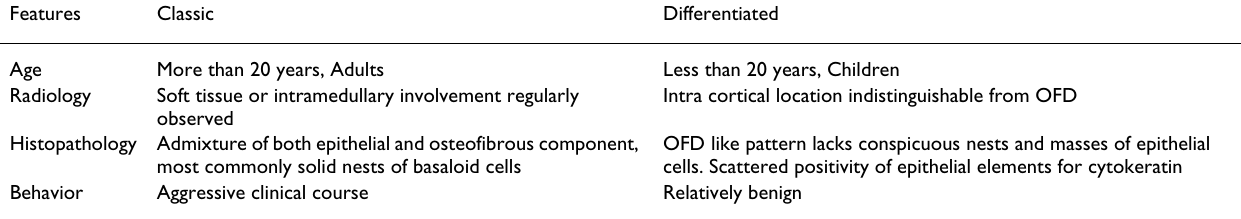
Table 2: Classification of Adamantinoma